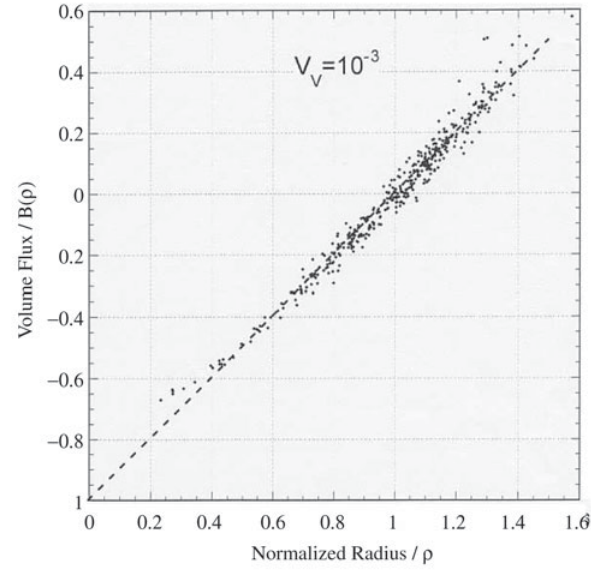
Figure 6. Volume flux per steradian, B( ρ ), versus scaled particle radius, ρ . Data are simulated from the multiparticle diffusion model for a microstructure with a dispersoid volume fraction V Note the broadened noise band as compared to that in Fig. 5.